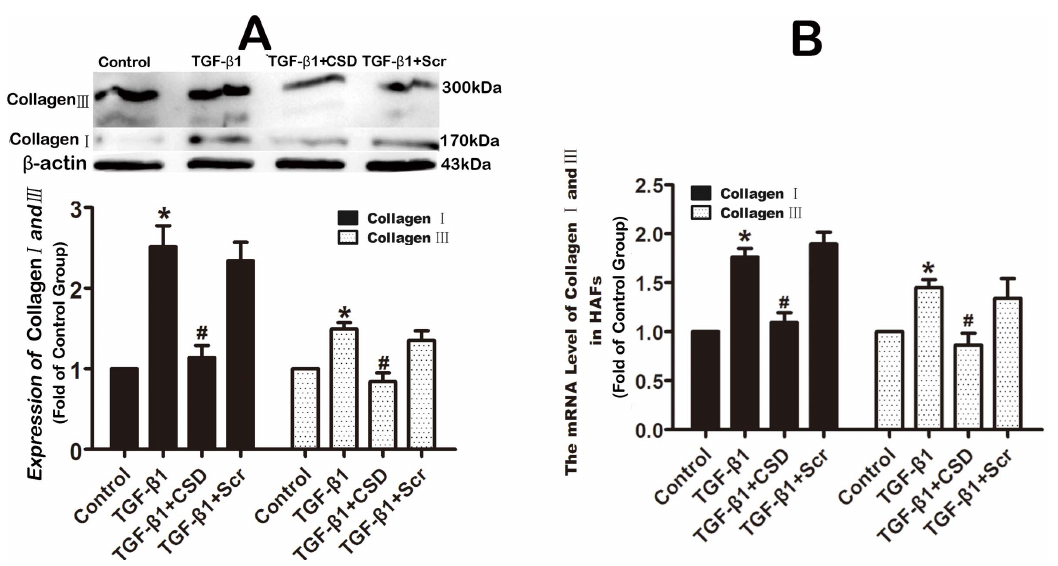
Figure 10. The CSD peptide inhibited TGF- b 1-induced upregulation of collagens in HAFs. HAFs were pretreated with the CSD peptide at a concentration of 5 m M or the Scr peptide (5 m M) for 30 min, and subsequently incubated with or without 100 ng/ml TGF- b 1 for 48 h for western blot or 24 h for qRT-PCR. Note that the CSD peptide pronouncedly abrogated the TGF- b 1-induced increased protein level (A) and mRNA level (B) of collagens. HAFs, human atrial fibroblasts. The CSD peptide, peptides derived from the scaffolding domain of Cav-1. Scr peptide, scrambled peptide. *P , 0.05 vs. Control; # P , 0.05 vs. TGF- b 1; n=4 per group; measurement in triplicate for each single experiment.